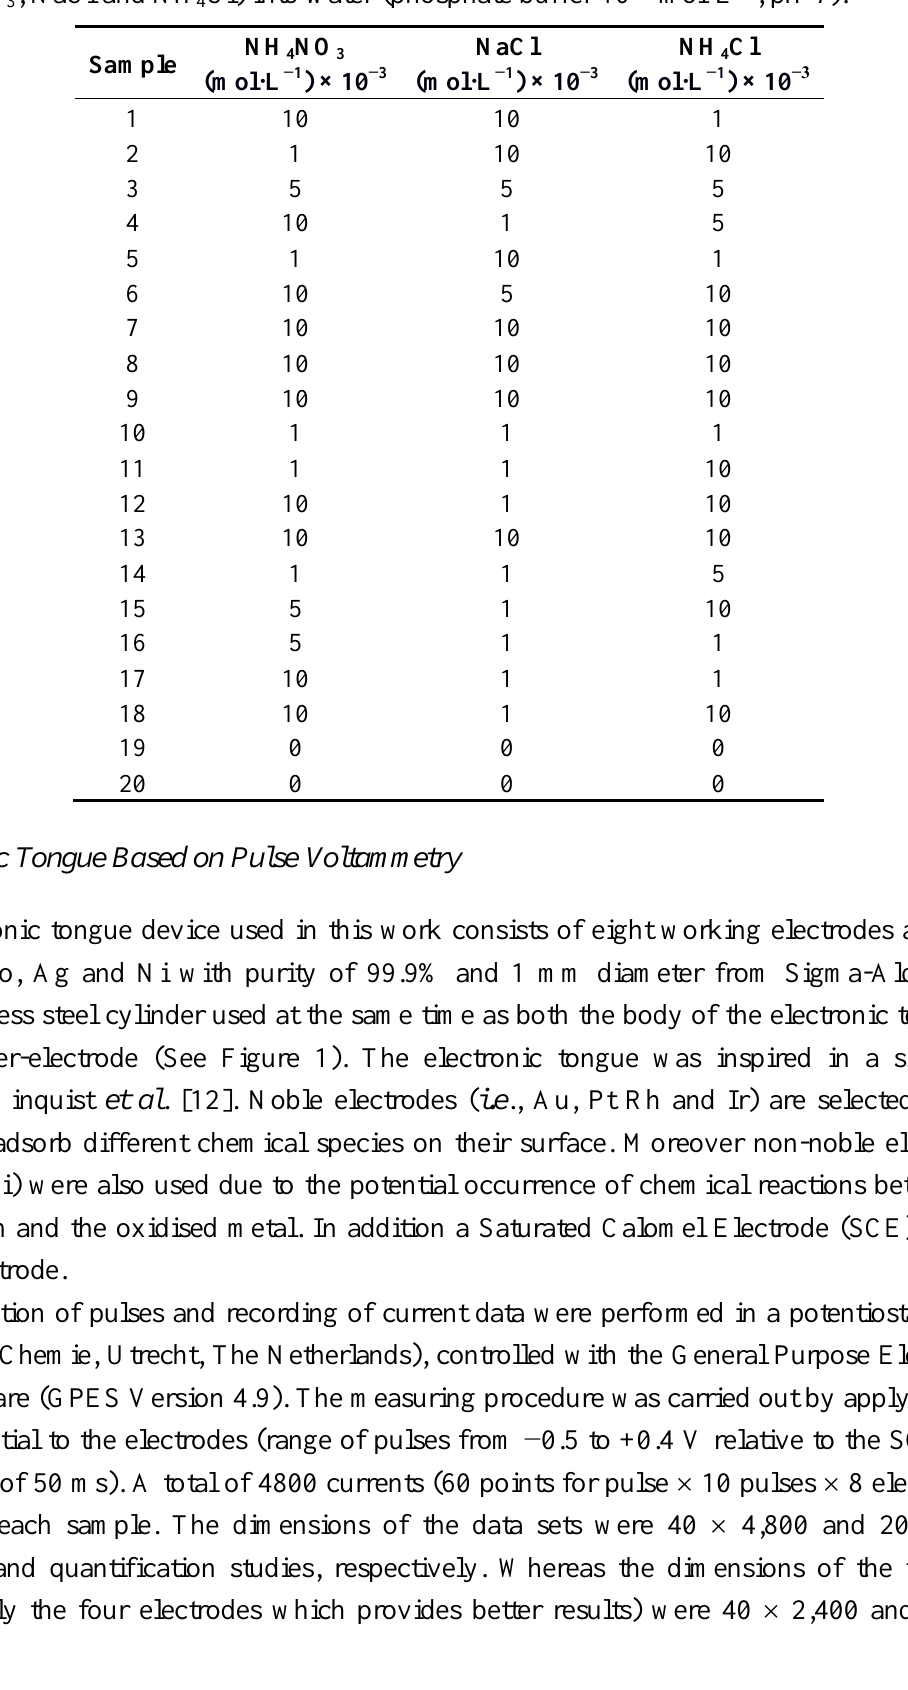
Table 1. Concentrations of samples prepared by addition of three selected